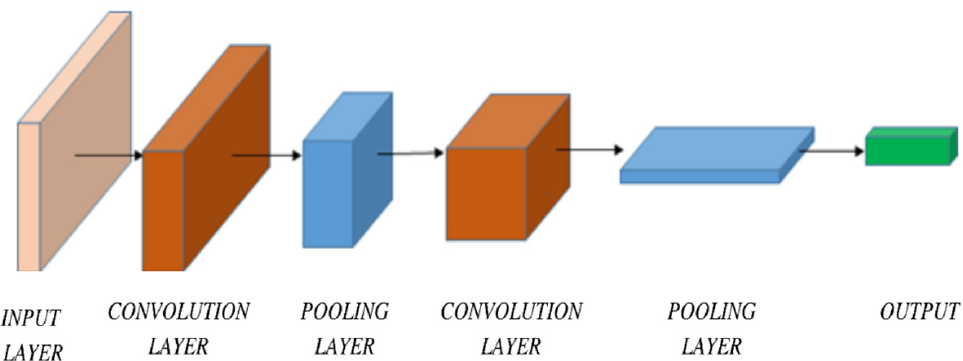
Figure 13. Basic structure of a Deep Convolutional Neural Network.